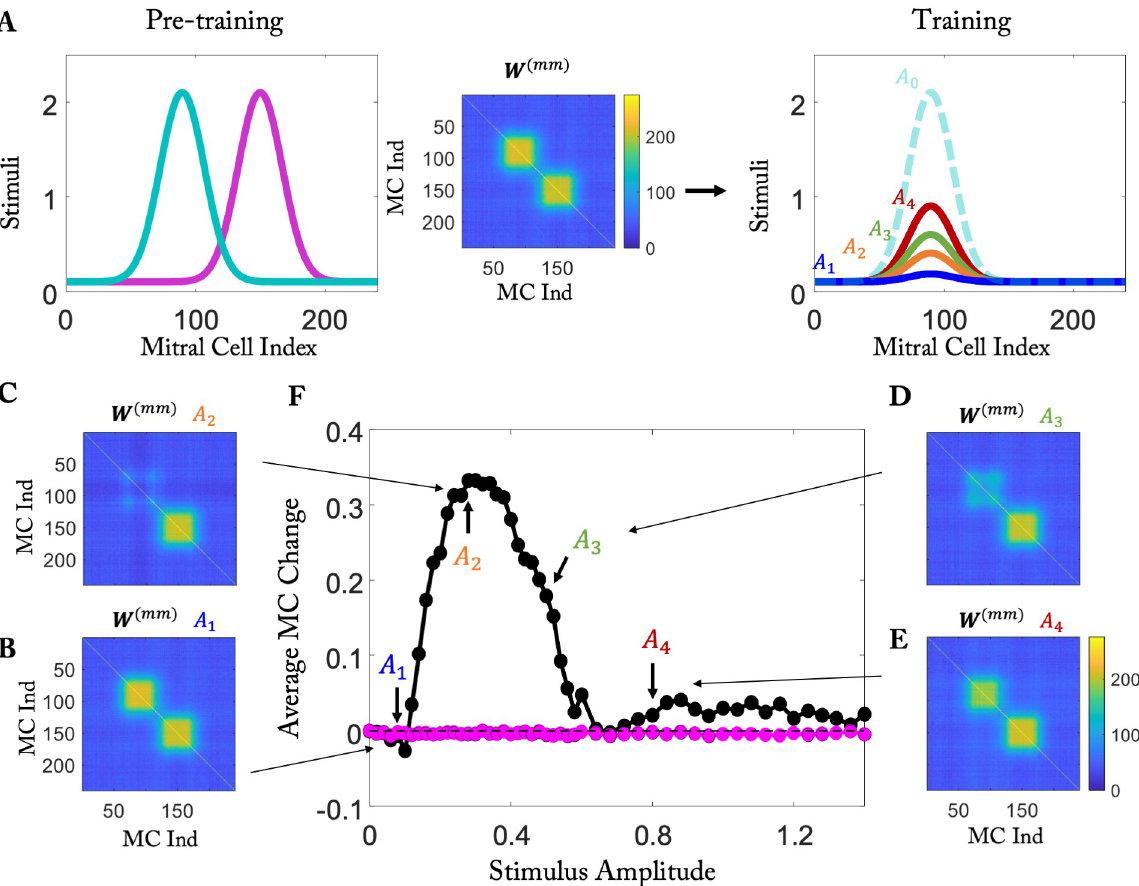
Fig 7. Removal of connections for intermediate GC activation. (A) Pre-training with two odors, then training with only one of the two odors at different amplitudes A 1 ... 4 . (B to E) The connectivities W ( mm ) resulting from the training depend non-monotonically on the stimulus amplitude A 1 ... 4 during training. (F) Non-monotonic mean change in the response to odor A after training as a function of the amplitudes A 1 ... 4 used in the